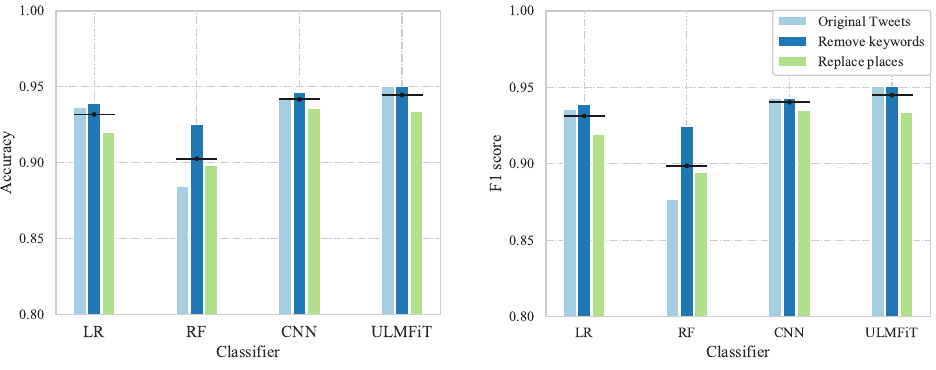
Figure 5. Accuracy and F1 score for the four text classifiers using the three model variants, with the average marked with a black